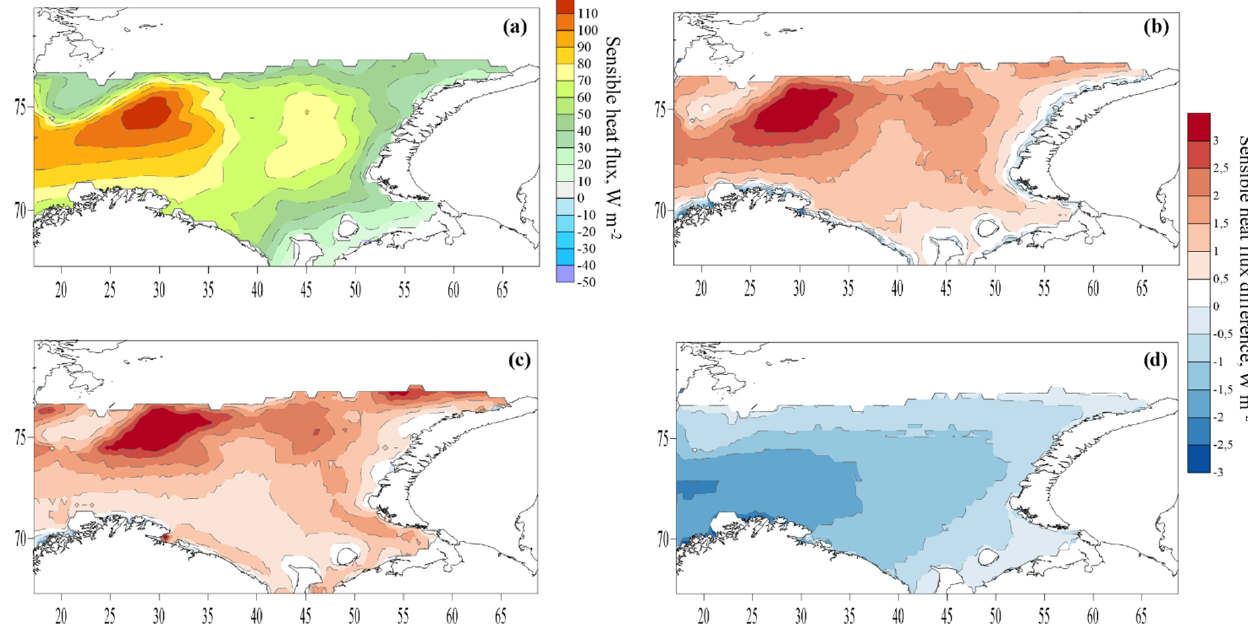
Figure 16. Mean sensible heat flux in experiment C55 (a) and the flux difference in experiments T1–C55 (b) , O2–C55 (c) and D3–C55 (d) during cold-air outbreaks.